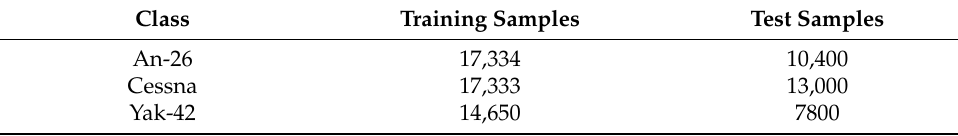
Table 1. HRRP data of known classes